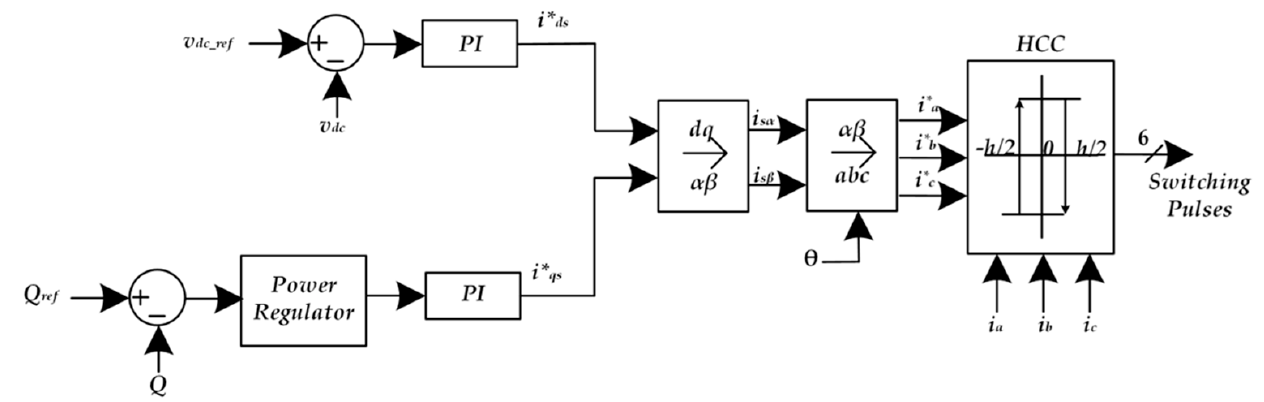
Figure 22. Hysteresis Current Control Strategy with two control loops.